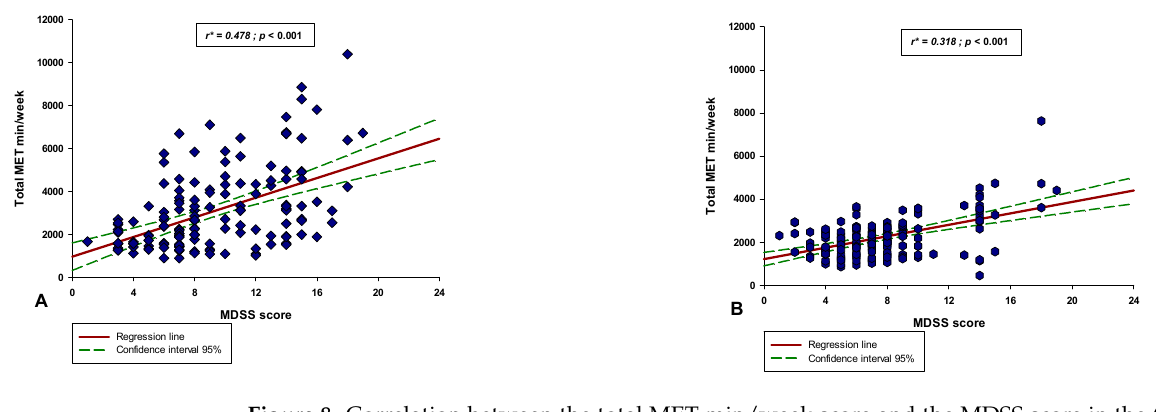
Figure 8. Correlation between the total MET min/week score and the MDSS score in the ( A ) professional athlete group ( N = 150) and in the ( B ) recreational athlete group ( N = 150). * Spearman’s correlation coefficient.